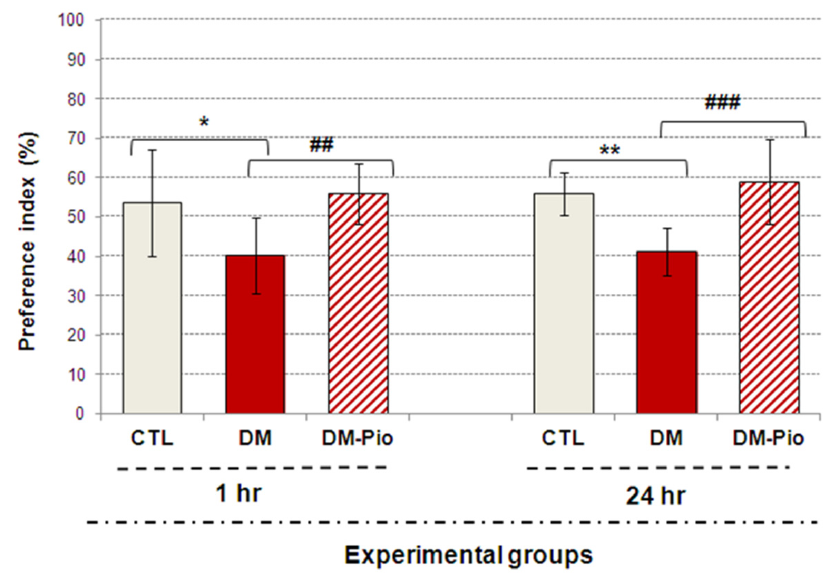
Figure 3. Effect of pioglitazone on impaired memory of mice with neuroinflammation related with diabetes. The bar height represents the mean ± SD for individual experimental groups: CTL: non-diabetic mice, DM: diabetic mice, DM-Pio: pioglitazone-treated mice [30 mg/kg, po ]. One-way ANOVA, followed by Tukey’s post hoc test was used. * p < 0.05; ** p < 0.01 in comparison with control group. ## p < 0.01; ### p < 0.001 in comparison with diabetes group.